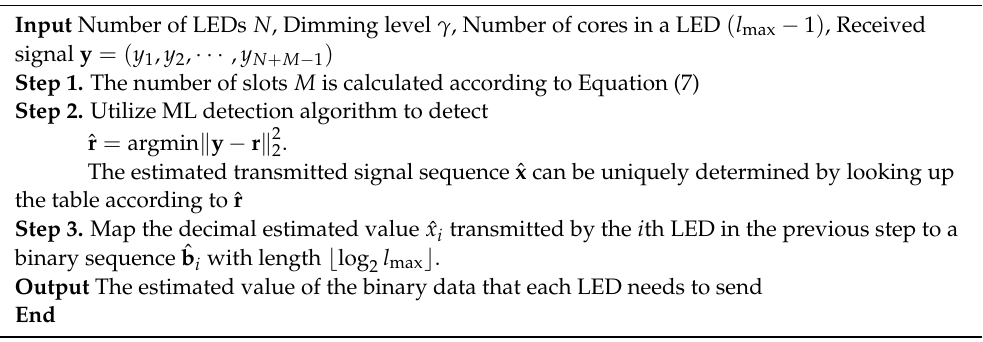
Algorithm 2: Decoding Algorithm of the ML-MTSC